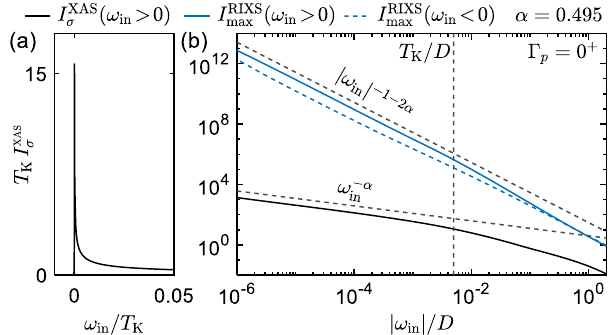
FIG. 11. XAS spectrum I XAS σ ð ω ( U= Δ ¼ 1 = 5 , Δ =D ¼ 1 = 25 , U T=D ¼ 10 − 7 , ω as for Fig. 8. The power law I XAS ∼ ω − α quantitatively matches the prediction of Eq.